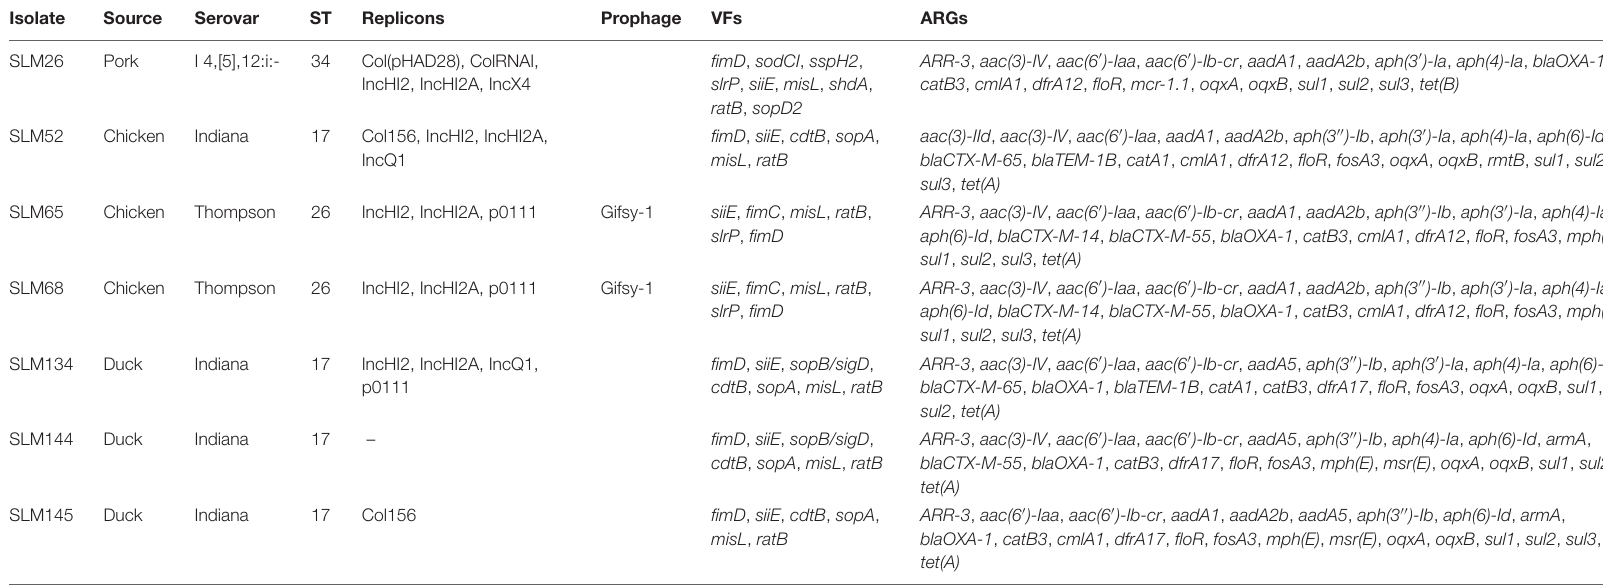
TABLE 2 | Sources and serovar, ARG, VF, and ST profiles of some Salmonella isolates. Isolate Source